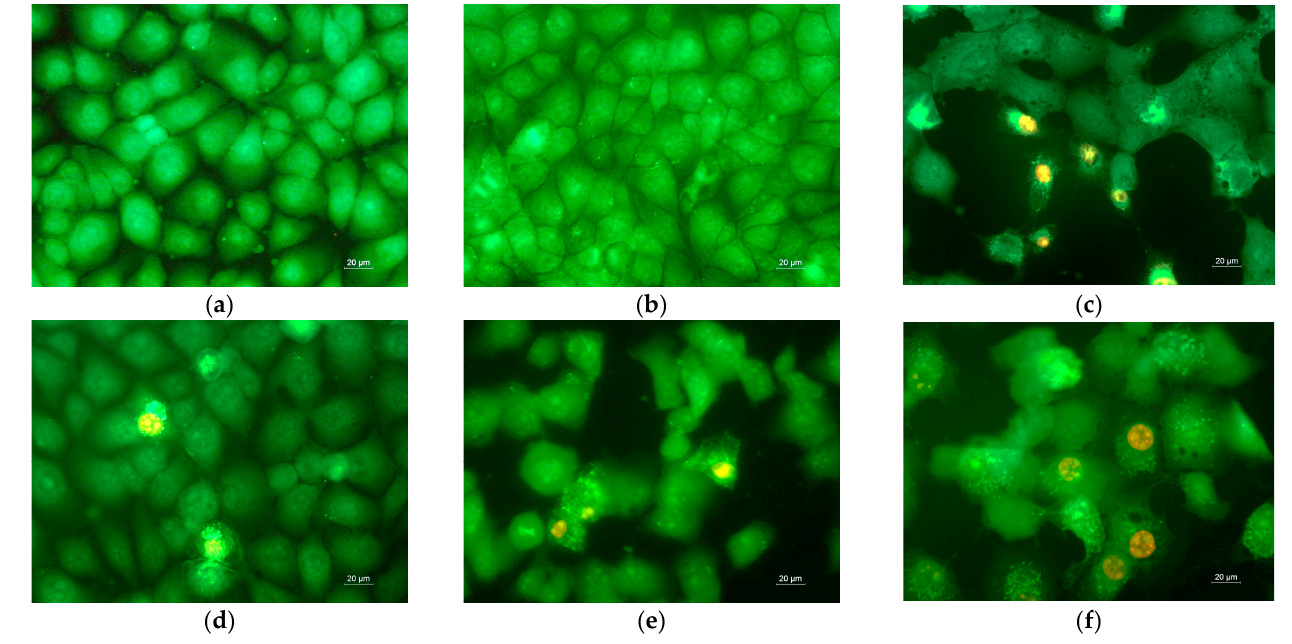
Figure 9. Fluorescence images of AO and EtBr double-stained HeLa cancer cells incubated for 24 h: ( a ) untreated cells and after incubation with ( b ) CA/PEG fibrous mat, ( c ) CA/PEG/QUE fibrous mat, ( d ) CA/PEG/RUT fibrous mat, ( e ) CA/PEG/QUE/RUT fibrous mat, and ( f ) CA/PEG/QUE+CA/PEG/RUT fibrous mat; bar = 20 μ m.